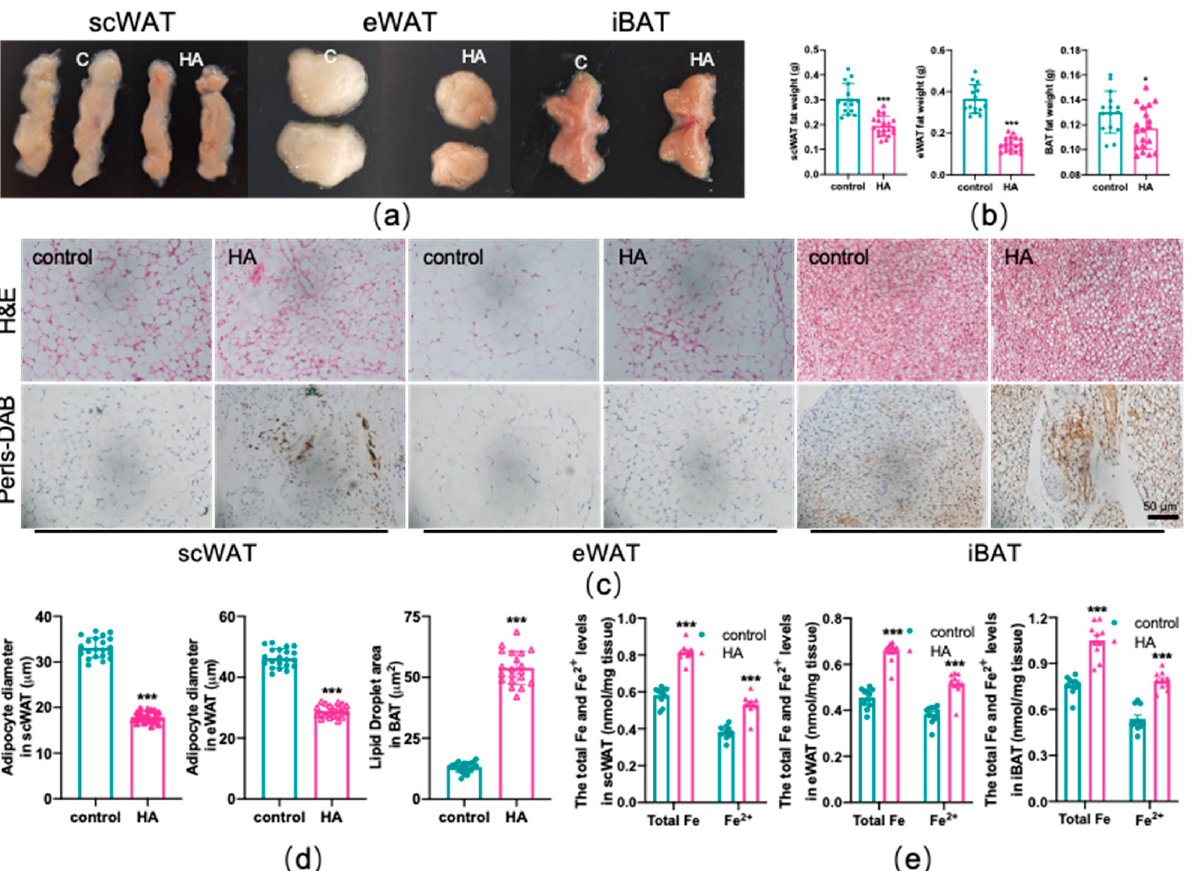
Figure 2. Reduced adipocyte hypertrophy and iron overload in adipose tissue due to HA exposure. ( a ) Representative images of scWAT, eWAT, and iBAT in mice. ( b ) Adipose tissue weight. ( c ) Representative images of fat pad sections stained with H&E and DAB enhanced Perls’ staining. ( d ) Diameter of adipocytes. ( e ) Total and ferrous iron content assay by colorimetry ( n = 10). Labeled asterisks represent statistical significance in comparison with the control. * p < 0.05, and *** p < 0.001.